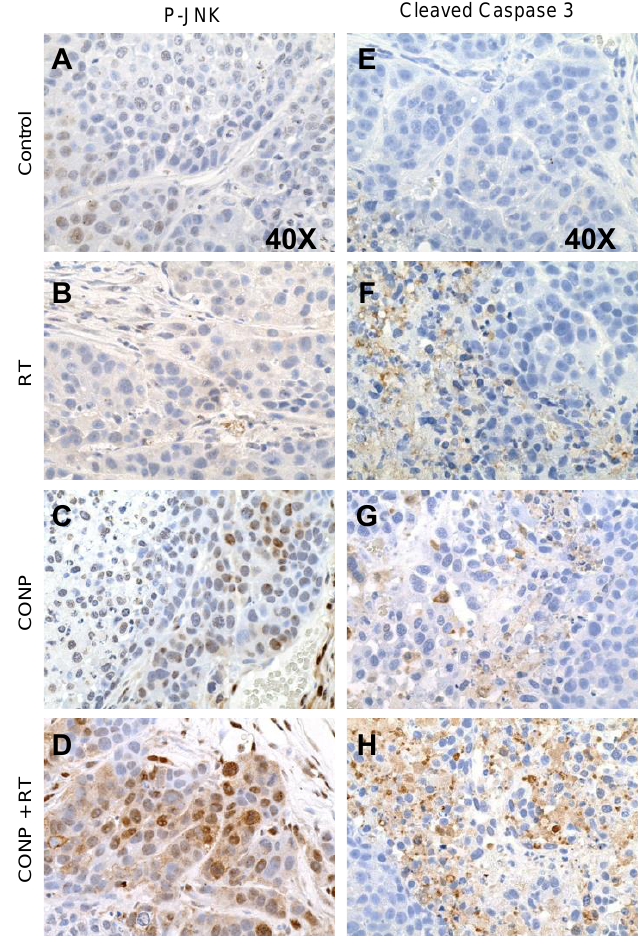
Figure 5. CONPs Enhance RT-Induced Activation of Apoptotic Signaling in the L3.6pl Tumor Cells in vivo. The pancreatic tumors were developed as described in the Materials and Methods section.